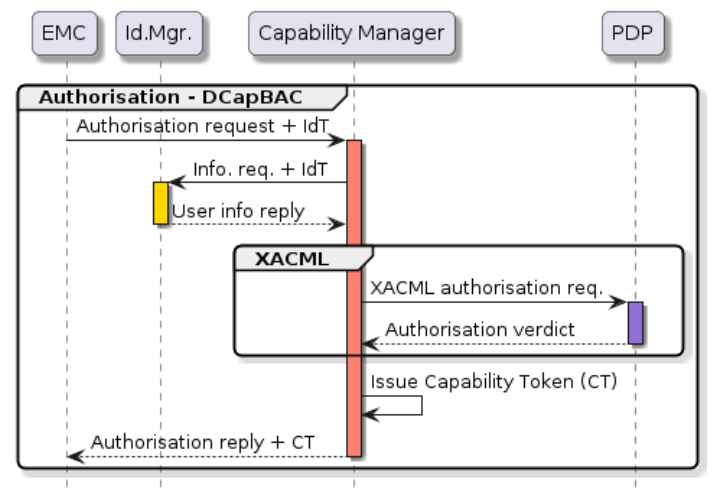
Figure 9. Authorisation